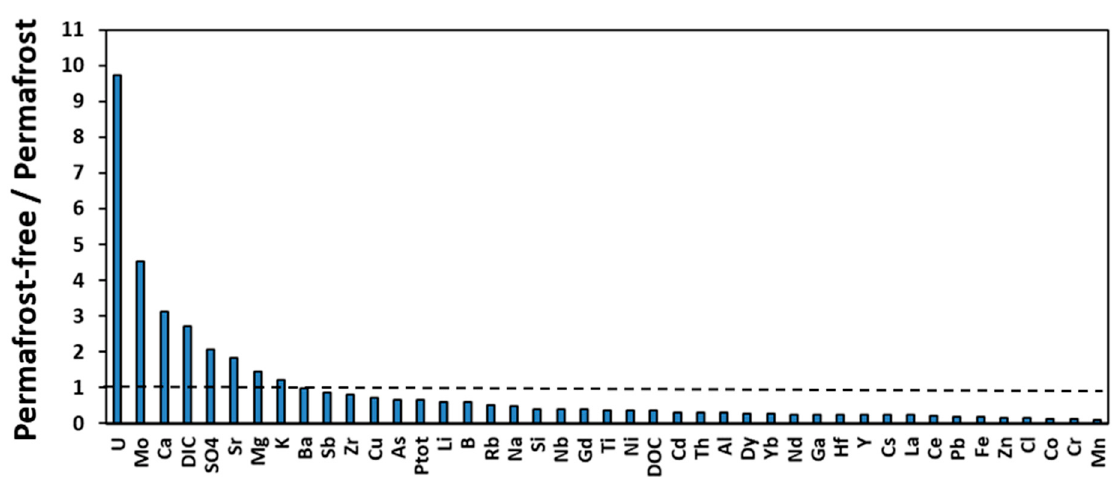
Figure 4. A histogram of the ratio of element average yield in the permafrost-free rivers to that in the permafrost-affected rivers for 6 open-water months (May to October) of 2016 (based on the data listed in Table 1).